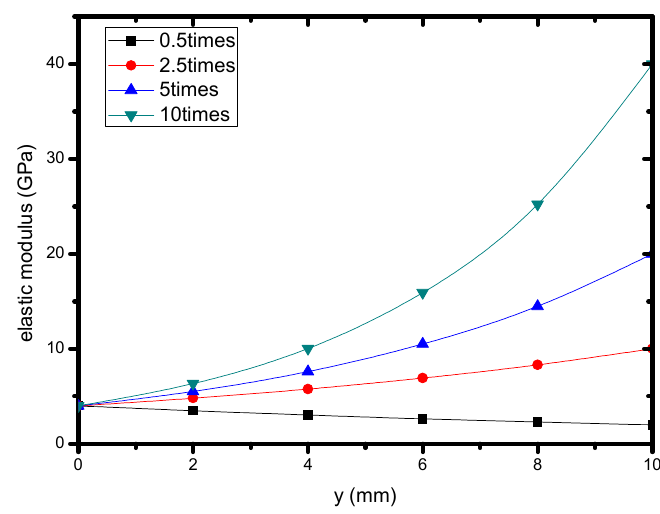
Figure 11. The ratio of the elastic moduli of different gradient coatings.